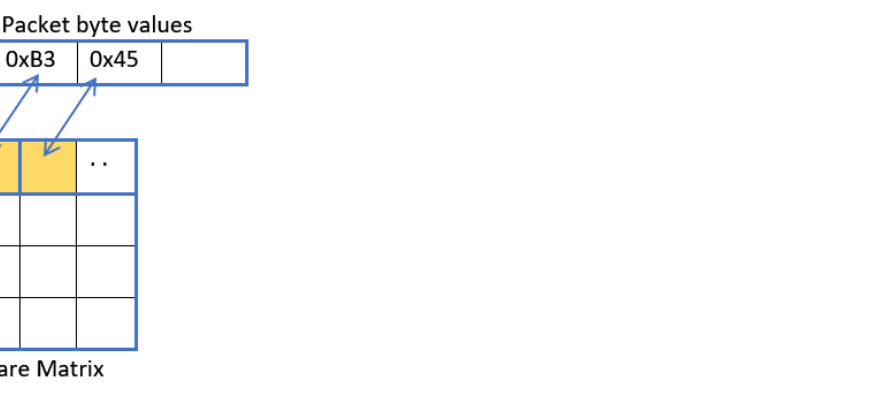
Figure 3. Mapping packet byte values into pixels (Recreated with permission from ref. [14]. Copyright 2022